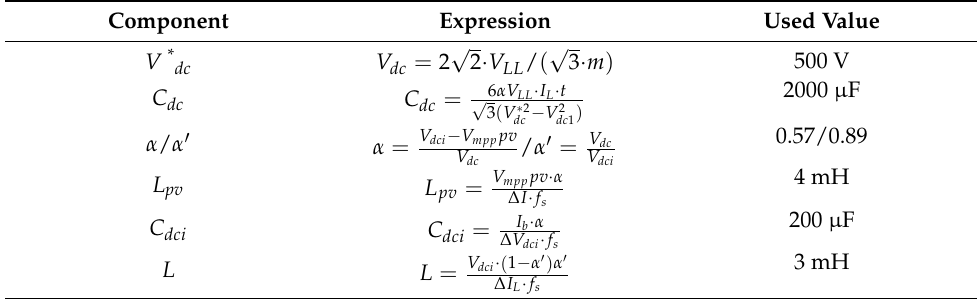
Table 2. Parameters of boost-buck